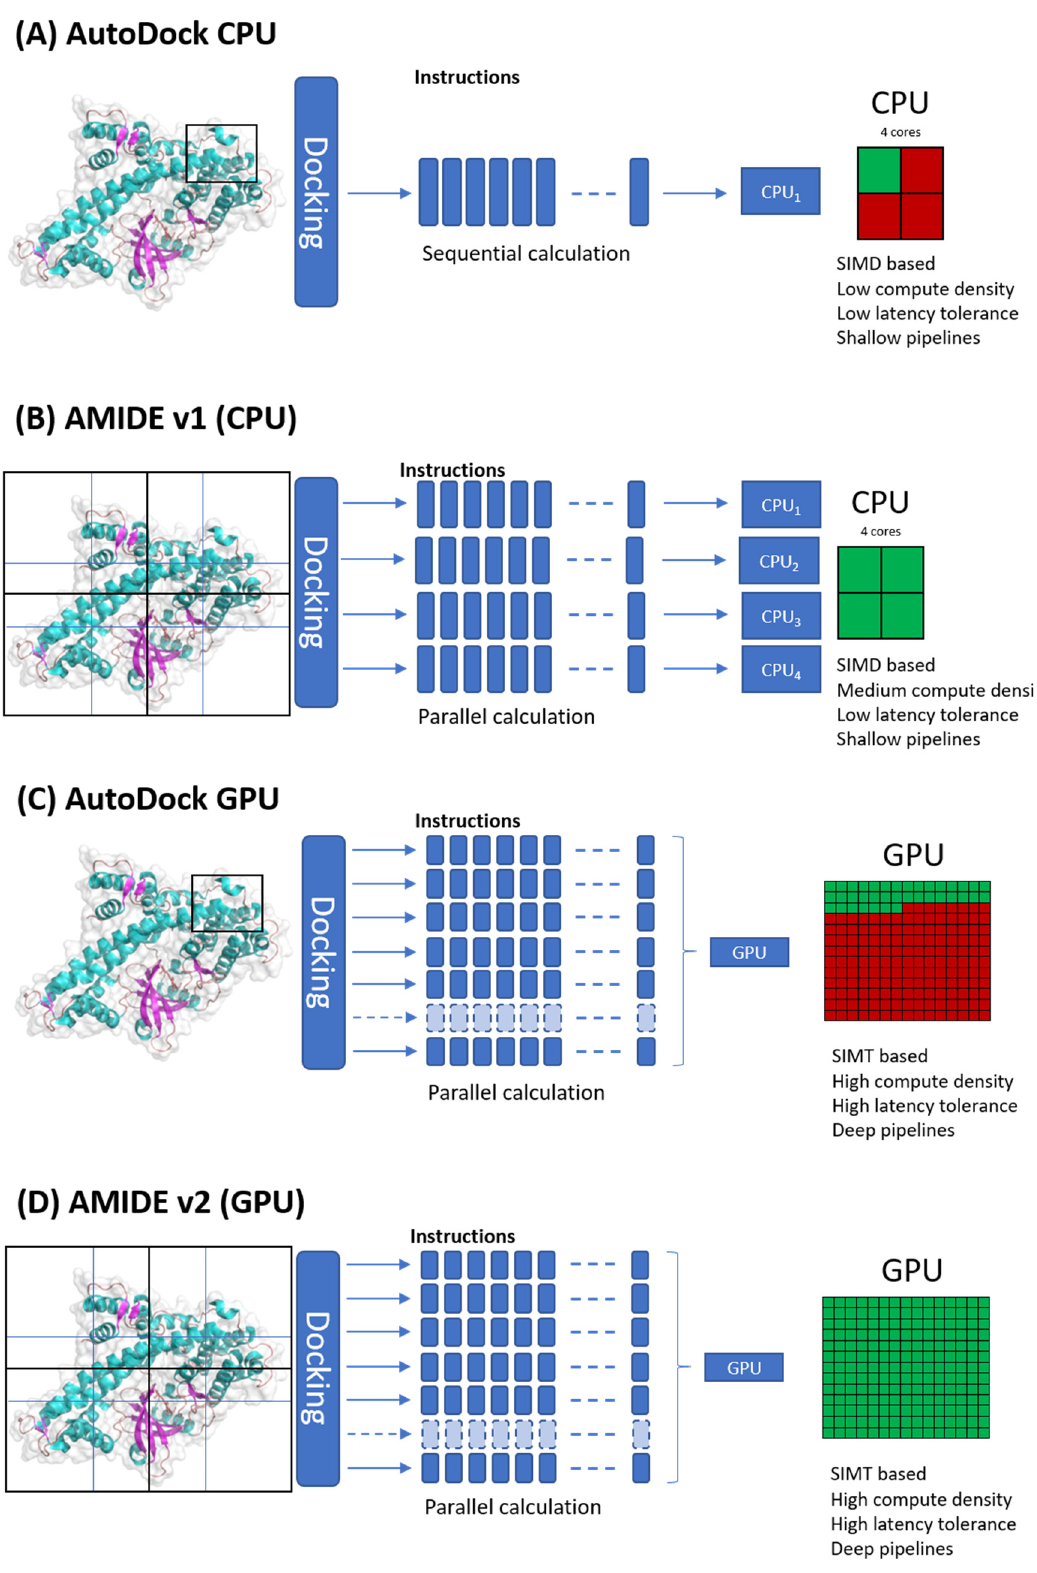
Figure 1. Comparison of AutoDock 4.2 (CPU), AutoDock-GPU and the two versions of AMIDE framework. While AutoDock standalone software can only dock one manually defined box at once ( A ), the AMIDE protocol automatically cuts the receptor into preselected overlapping boxes. AMIDE v1 boxes were independently sent to all available CPU cores ( B ). AutoDock-GPU is based on embarrassingly parallel capacities and can obtain multiple docking calculations in input ( C ). AMIDE v2 is now using GPU based parallelization, allowing time calculation decrease by computing multiple dockings at once ( D